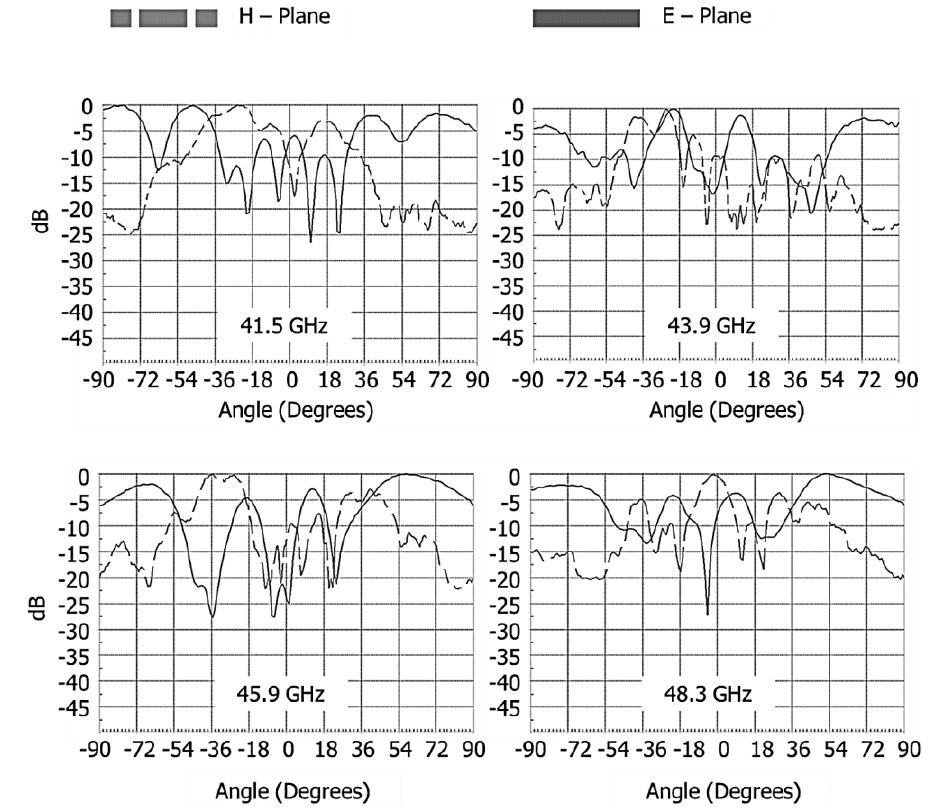
Figure 4. Simulated radiation pattern of the proposed array antenna.